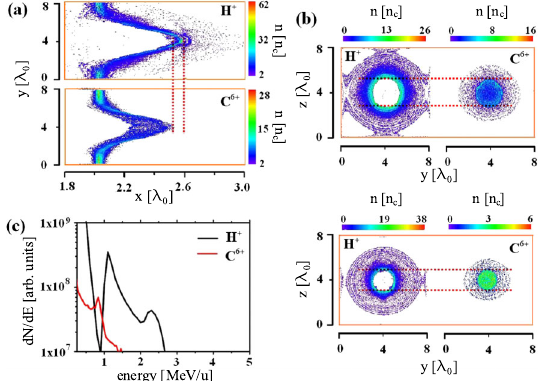
FIG. 2. Data from 3D-PIC simulation. (a) Spatial proton and carbon ion density distribution in the x - y plane at z ¼ 4 (cid:1) t ¼ 54 fs after the arrival of the laser pulse. Obviously, the protons move ahead of the carbon ions. (b) Proton and carbon ion density distribution in the y - z plane at x ¼ 2 : 3 (cid:1) x ¼ 2 : 4 (cid:1) (below) at the same time to indicate that the protons 0 are always located outside of the carbon ion distribution. (c) Spectral distribution of protons (black) and carbon ions (red). The dashed red line in (a) and (b) illustrates the relative position of the proton with respect to the carbon